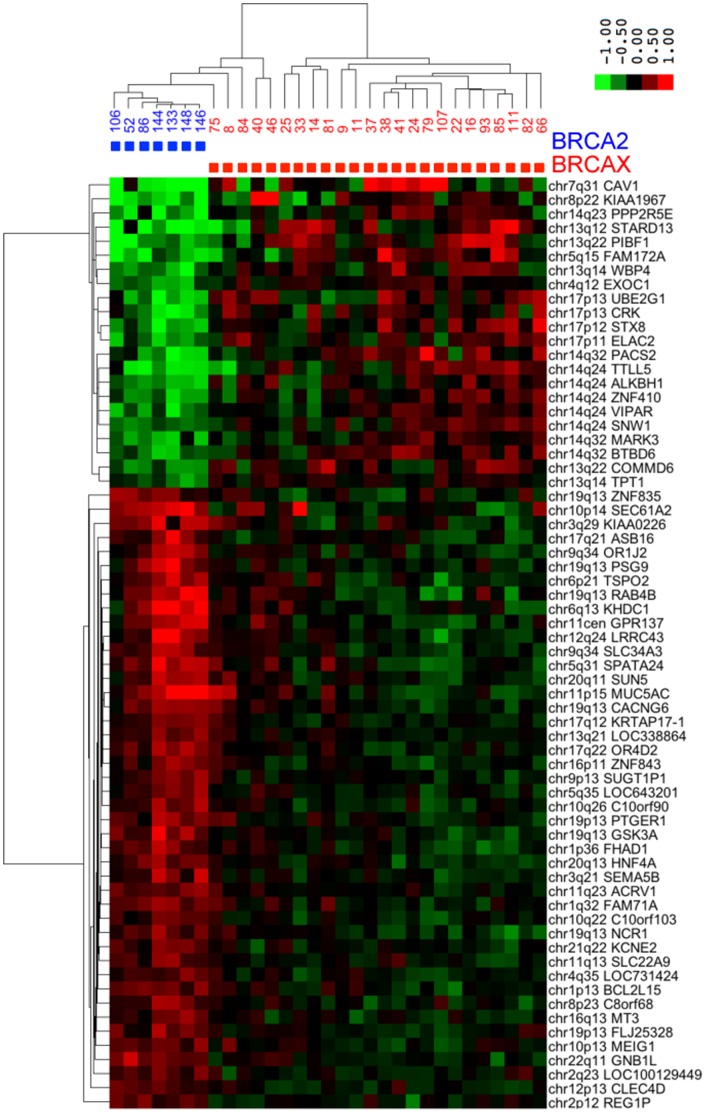
Unsupervised hierarchical clustering of the 66 BRCA2 signature genes in the training set.There are seven BRCA2-mutant tumors and 24 BRCAX tumors (tumors from patients lacking known BRCA1/2 mutations but with a familial history of breast cancer). The upper left quadrant contains many genes on 13q and 14q that show reduced expression in BRCA2 tumors.